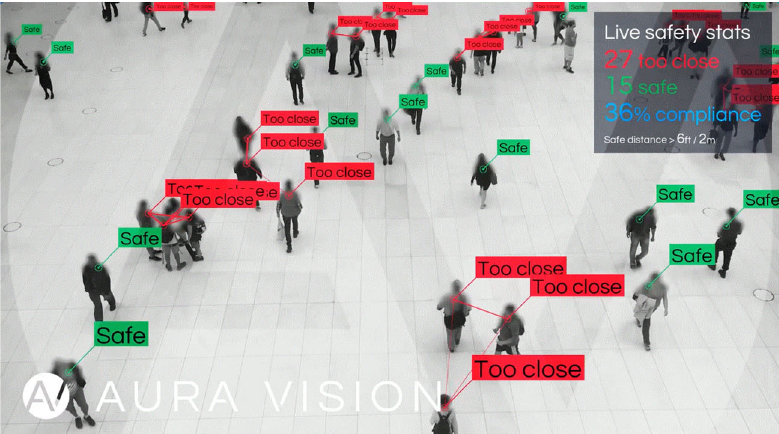
Fig. 3 Example of a computer vision solution for real-time monitoring of adherence to social distancing 26 . The image shows the movement of people through a public space and estimates compliance with distancing by at least 6 feet. Image courtesy of Aura Vision, used with